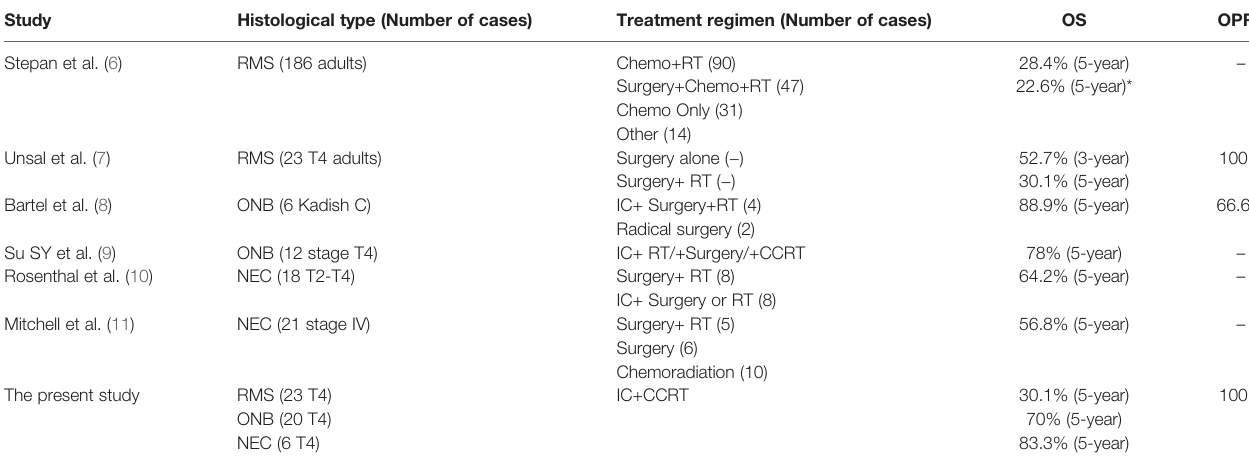
TABLE 6 | Comparison of OS and OPRs with different regimens for sinonasal